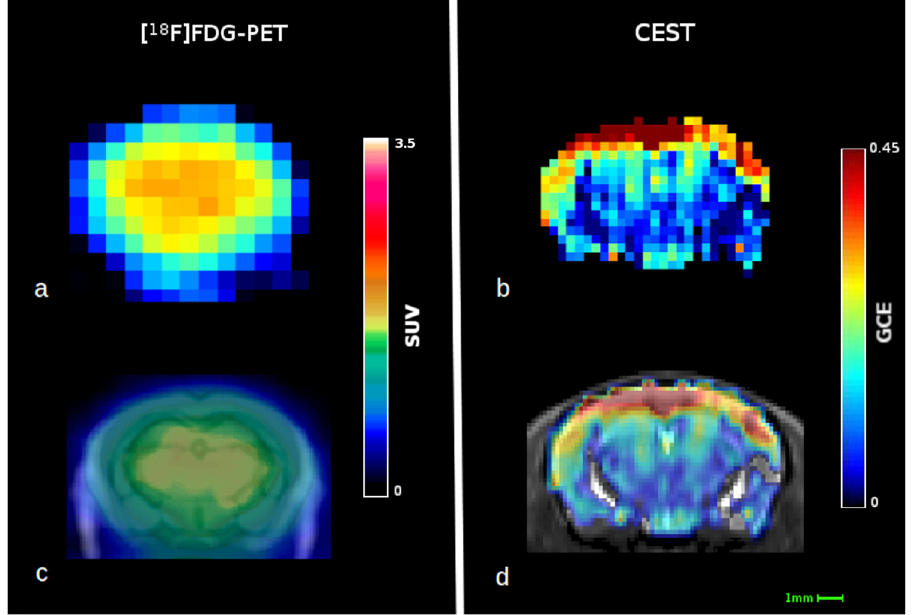
Figure 6. Fitting procedure. The left panel shows the location of the different compounds. Analysis firstly fitted the contribution of water and NOE (part A) and in a second step the other compounds contributions (part